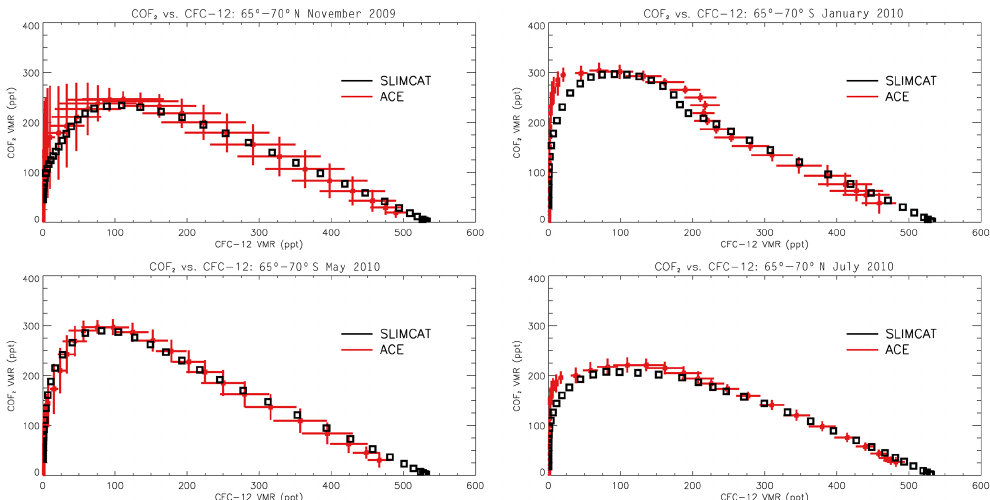
Figure 4. Correlation plots between coincident CFC-12 and COF 2 ACE-FTS observations and SLIMCAT calculations for Novem- ber 2009/July 2010 65–70 ◦ S and January/May 2010 65–70 ◦ N. The error bars represent the standard deviations in the ACE-FTS